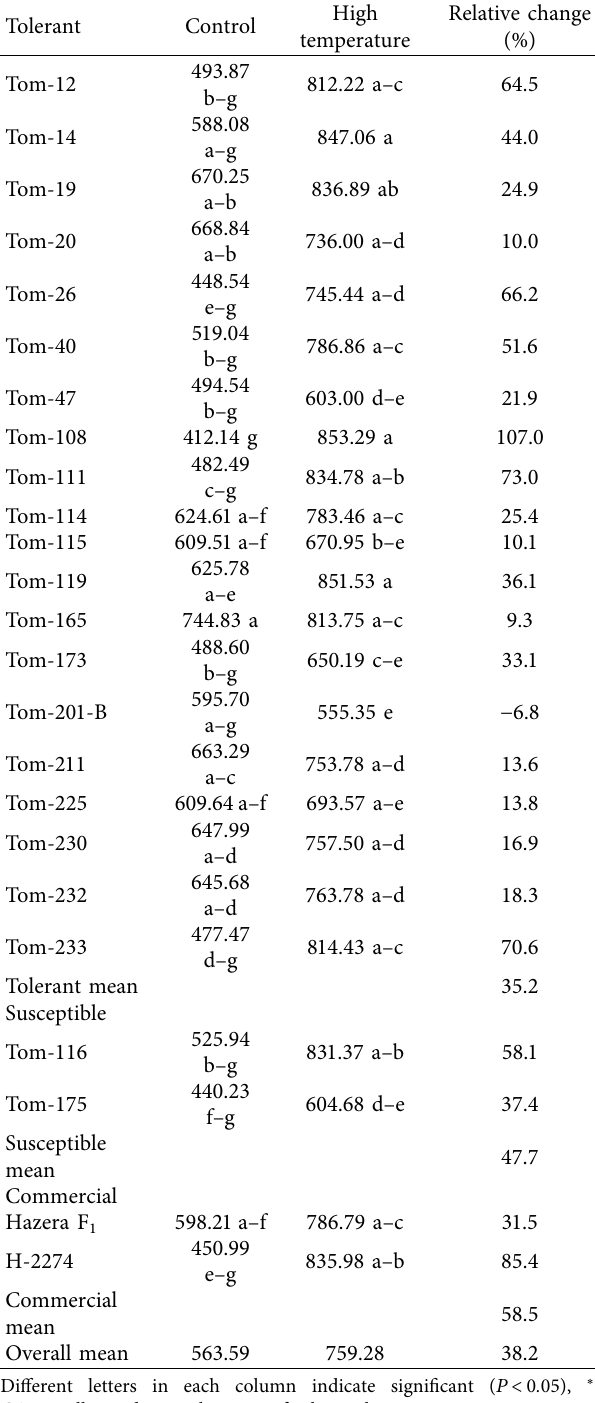
Table 7: Total phenolic content (TPC) of tomato fruits grown under control and high-temperature stress (mg GAE/100g